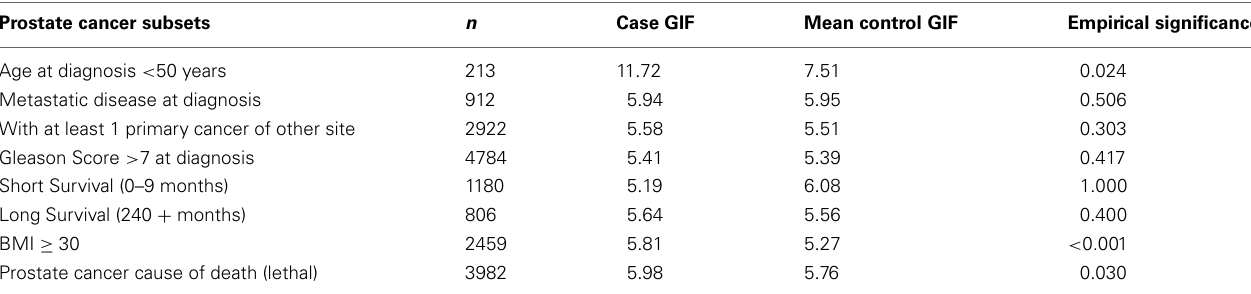
Table 3 | Subset prostate cancer relatedness compared to expected prostate cancer case relatedness in the UPDB. Prostate cancer